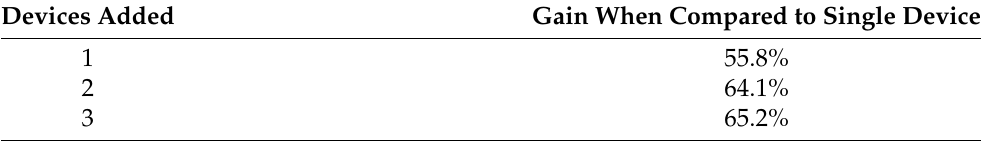
Table 2. Percentage of gain by adding